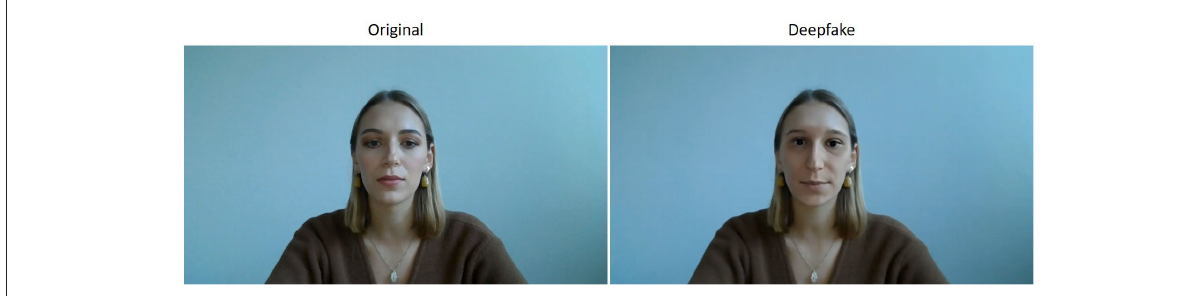
FIGURE1 Experimental stimuli = Original : Physically more attractive instructor; Deepfake : physically less attractive instructor.